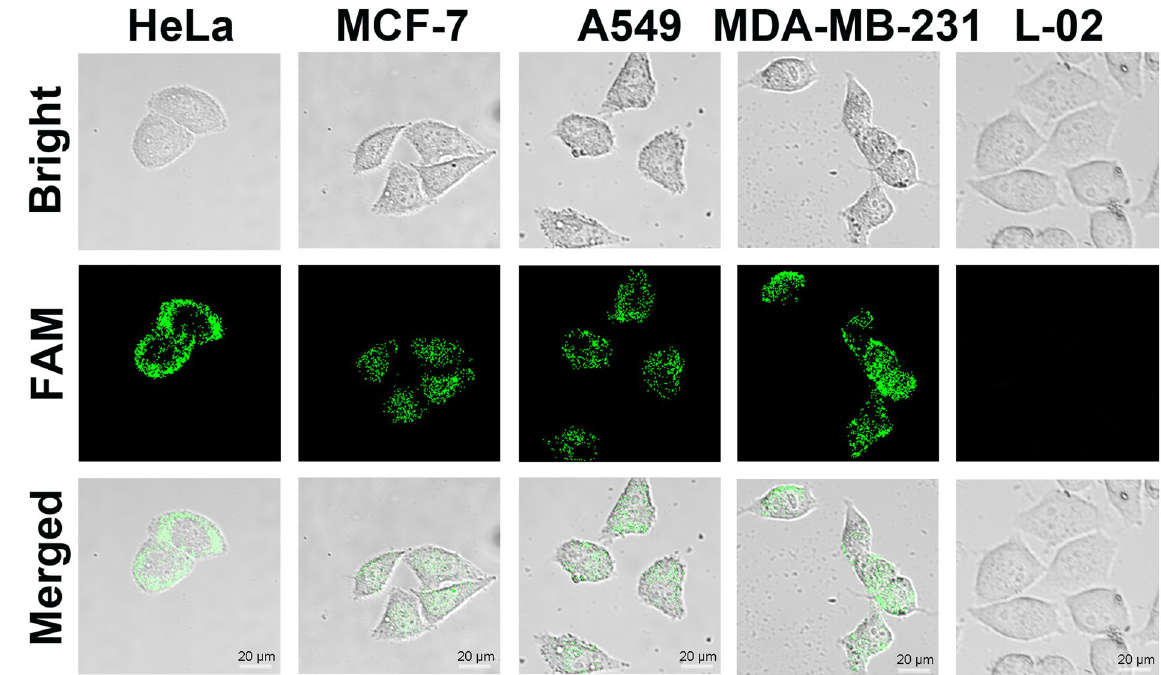
Figure 4. Confocal images for evaluation of DNA conformational switch-based AuNP-MPs for telomerase activity monitoring in individual cells: HeLa, MCF-7, A549, MDA-MB-231, and L-02 cells.